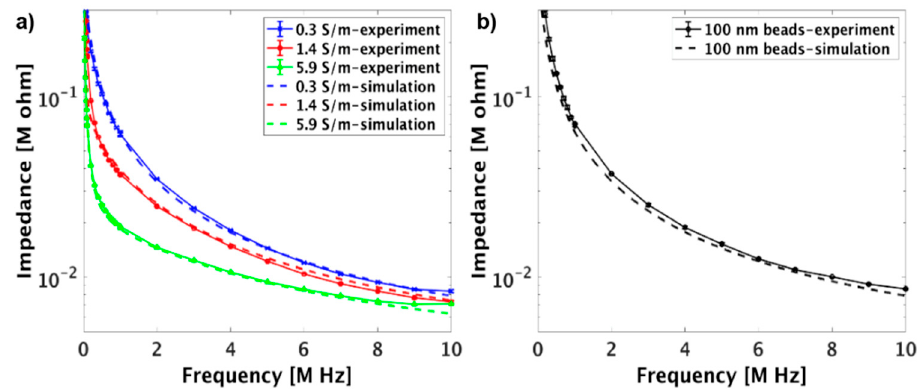
Figure 5. ( a ) The theoretical modeling and experimental results showing the impedance of solutions with different conductivities as a function of frequency. ( b ) The theoretical modeling and experimental results showing the impedance of COOH-PS beads suspended in 10 mM KCl. The error bars represent the standard deviation and each experiment was repeated at least three times.